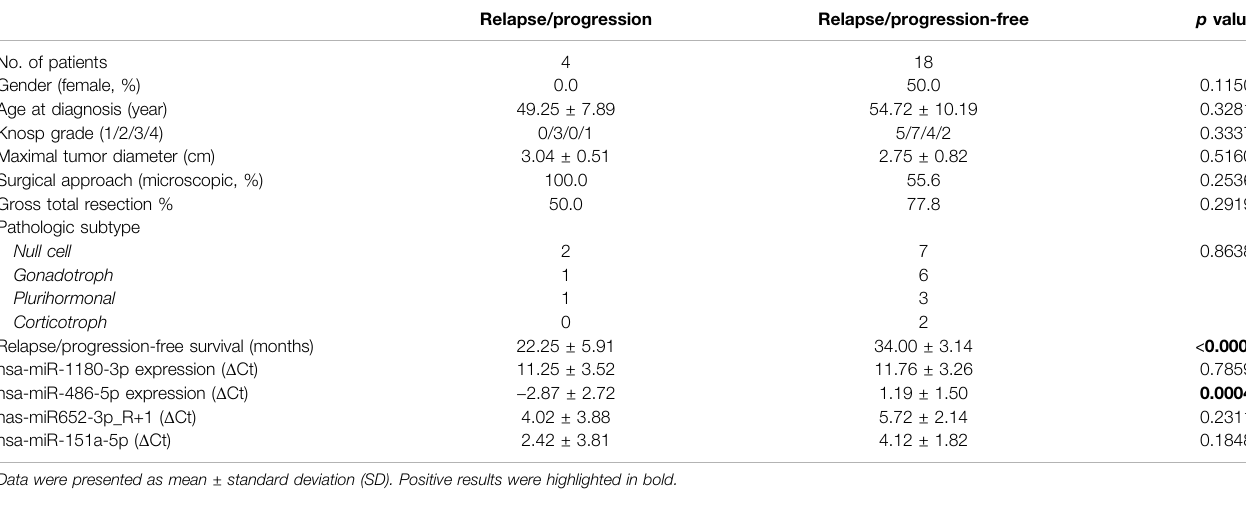
TABLE 1 | Follow-up outcomes of NFPA patients